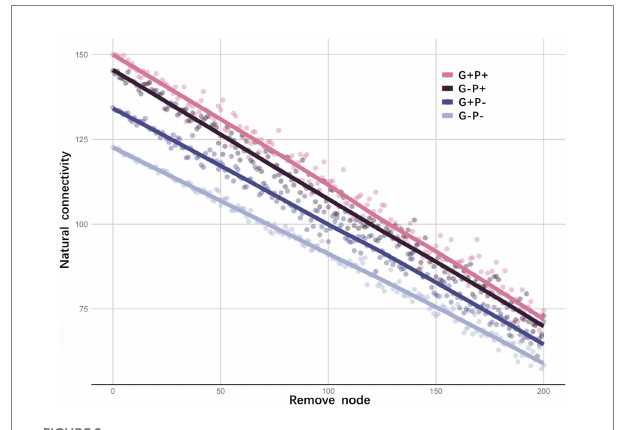
FIGURE 2 Invulnerability of networks with specialized metabolic functions under four treatments. The natural connectivity of each node is calculated by the adjacency matrix of the specialized functional network. Then 0–200 nodes are removed randomly. The redundancy of alternative pathways in the network is judged by the change trend of natural connectivity. Each point (node) represents a single gene in a specialized metabolic function, the y -axis represents the size of the network’s natural connectivity after the random removal of a given number of nodes, and the line represents the fitting of the trend of natural connectivity. The natural connectivity with no nodes removed indicates the network stability of the microbial